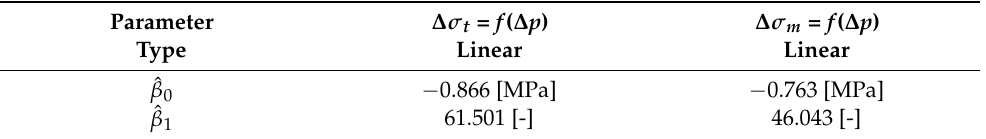
Table 1. Parameters of applied polynomial models of the first degree of individual regression dependencies.